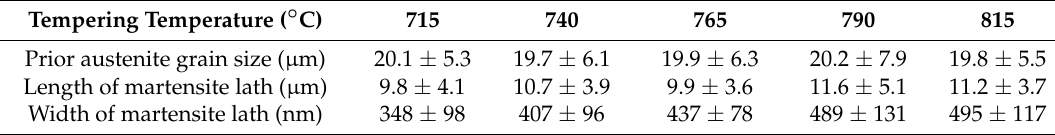
Table 2. Grain size of the T92 heat-resistant steels tempered at different